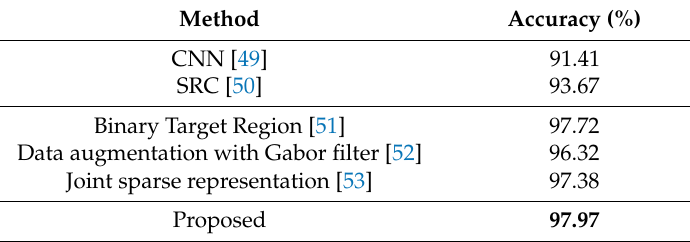
Table 9. Performance comparison with other